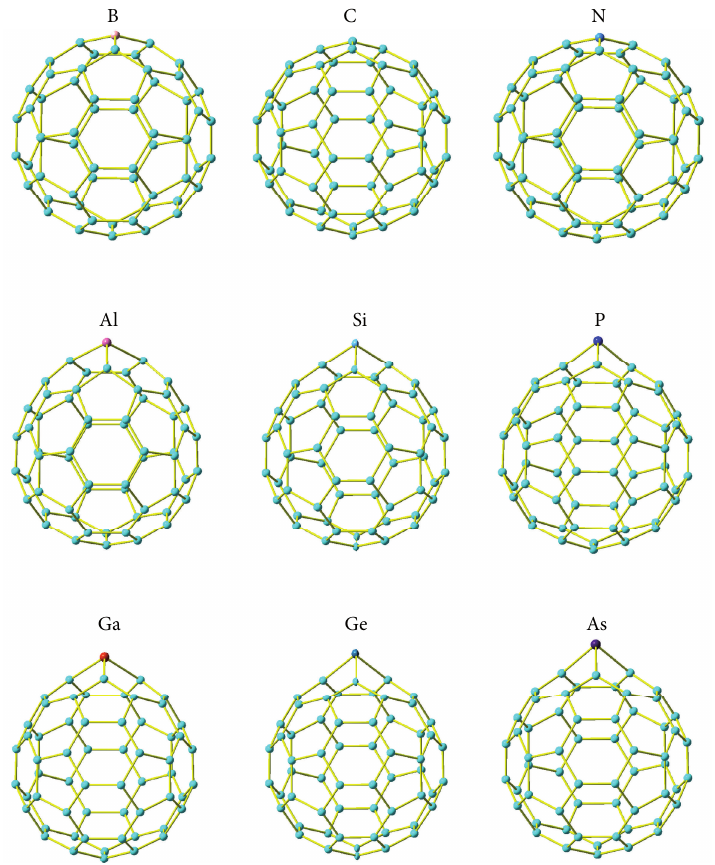
F 1: Structures of C